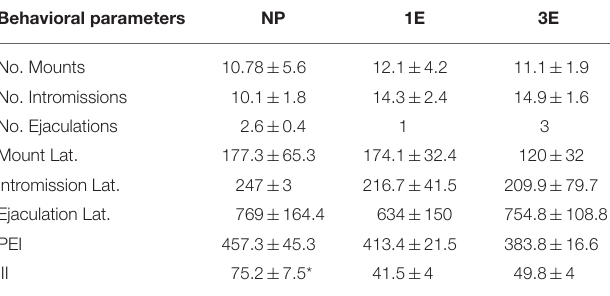
TABLE 1 | Data from the sexual behavior test in the different groups: no pacing (NP), one ejaculation (1E), and three ejaculations (3E); n = 8 per